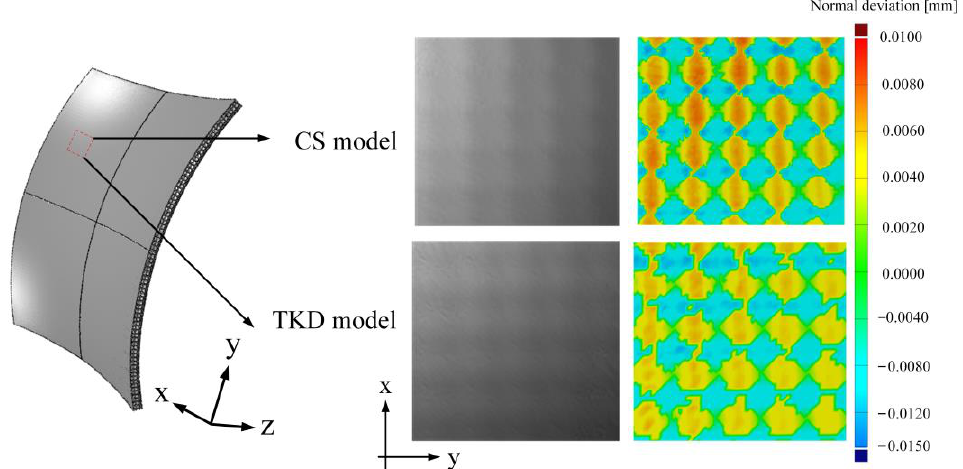
Figure 7. Surface dimpling of lower face sheet of saddle-shaped AFSP.